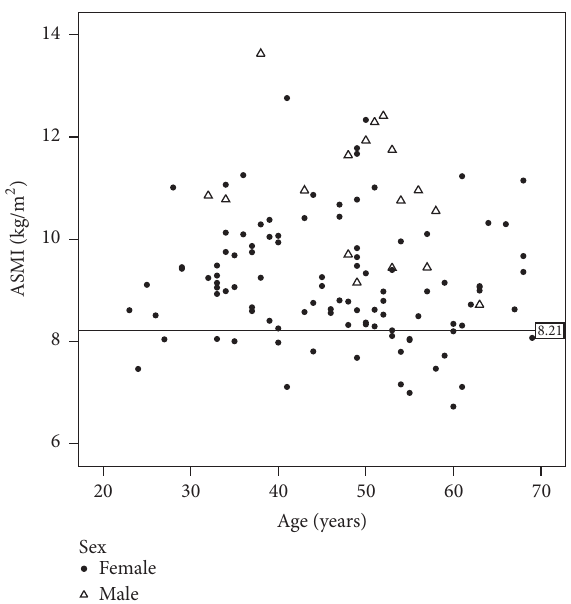
Figure 2: Variability of appendicular skeletal mass index (ASMI) by age (23–69 years) in adults with class II/III obesity ( 𝑛 = 120 , females = 103). The line indicated the 20th percentile of ASMI for females; subjects below this level ranged in age from 24 to 69 years.